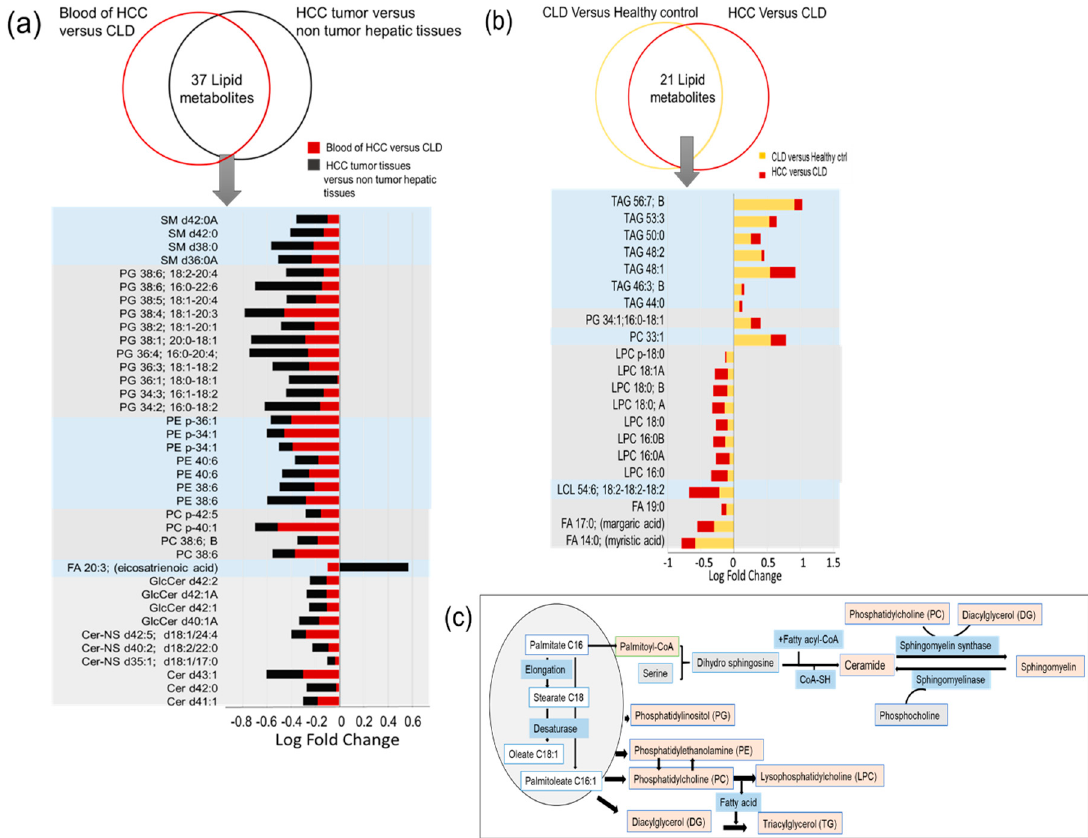
Figure 7. Lipid species that were found significantly dysregulated in the transition of CLD to HCC. ( a ) Common and shared significantly altered lipids in blood and tissues of the same HCC patients. ( b ) Significantly altered metabolites that share the same direction of alteration in the blood of HCC versus CLD patients and CLD patients versus healthy control subjects. ( c ) Metabolic pathways for synthesis of major lipid classes in the human body.